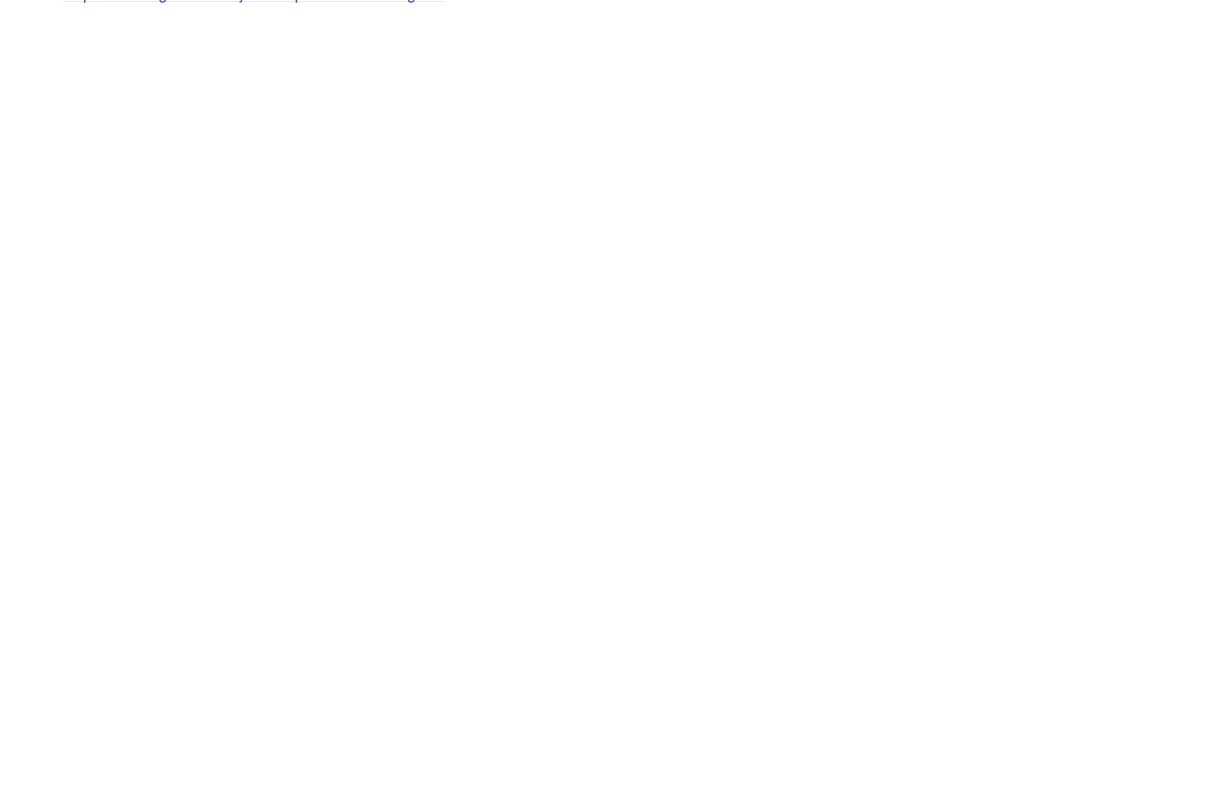
PLOS ONE | https://doi.org/10.1371/journal.pone.0279589 December19,